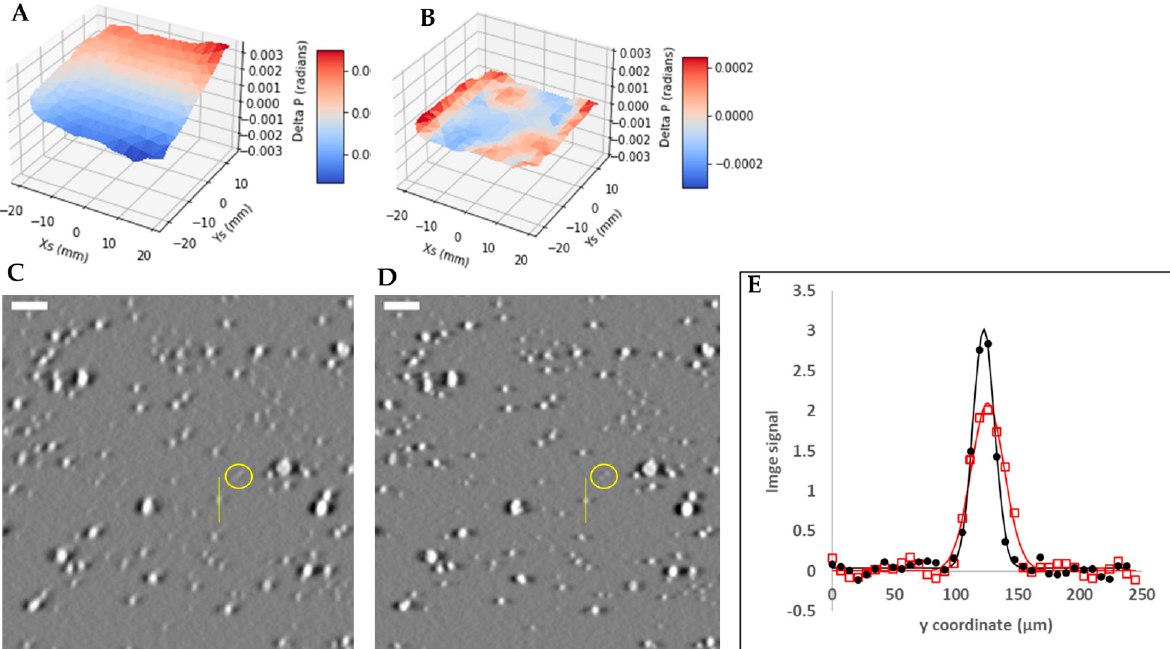
Figure 5. The effect of geometric calibration on the reconstructed image of a layer of hydroxyapatite particles. ( A ) is the surface plot of the deviation angles of the scan trajectories of the markers as a function of the marker position. The layer of the glass bead markers was fixed at 10 mm below the sample stage. ( B ) is the residual of the measurement in ( A ) after subtracting the fitted model of geometric calibration. ( C , D ) are the reconstructed images of the hydroxyapatite particles before and after applying the calibration. The yellow circles highlight the visible changes of the resolution of the particles. The scale bars are 160 µm. The yellow circles highlight two calcium specks that were only resolved after calibration. The line profiles across a calcium speck, marked by the yellow vertical lines in ( C , D ), are plotted in ( E ), where the red squares and red line are the measured signal profile and a Gaussian fit before calibration, and the black dots and black line are the corresponding quantities after calibration. The full width at half-maximum of the profiles were 31.7 and 20.5 µm before and after calibration, respectively.